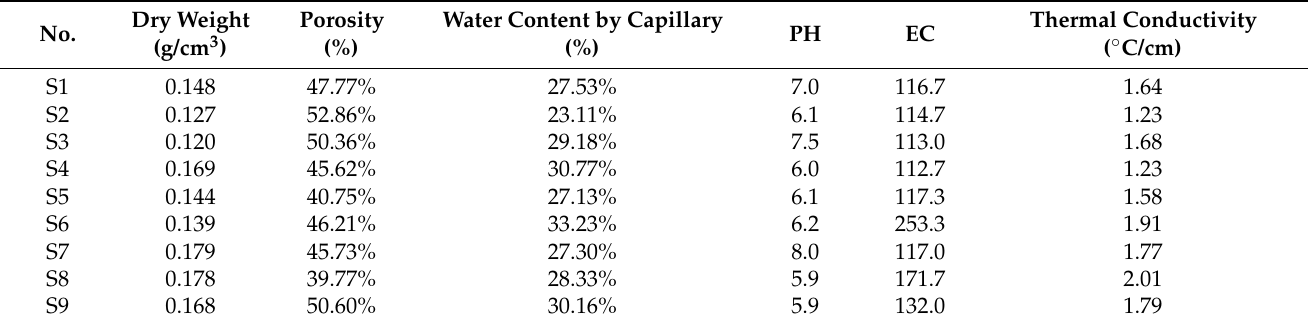
Table 3. Comprehensive comparison of 9 mixed